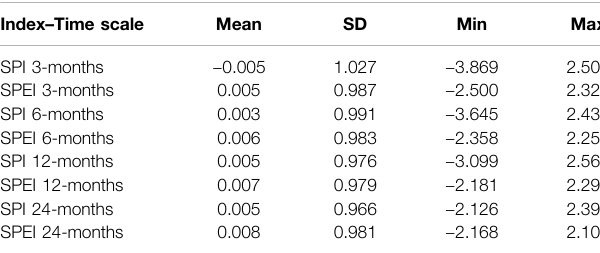
TABLE 2| Statistical summaryoftheSPIand SPEIindicesat differenttime